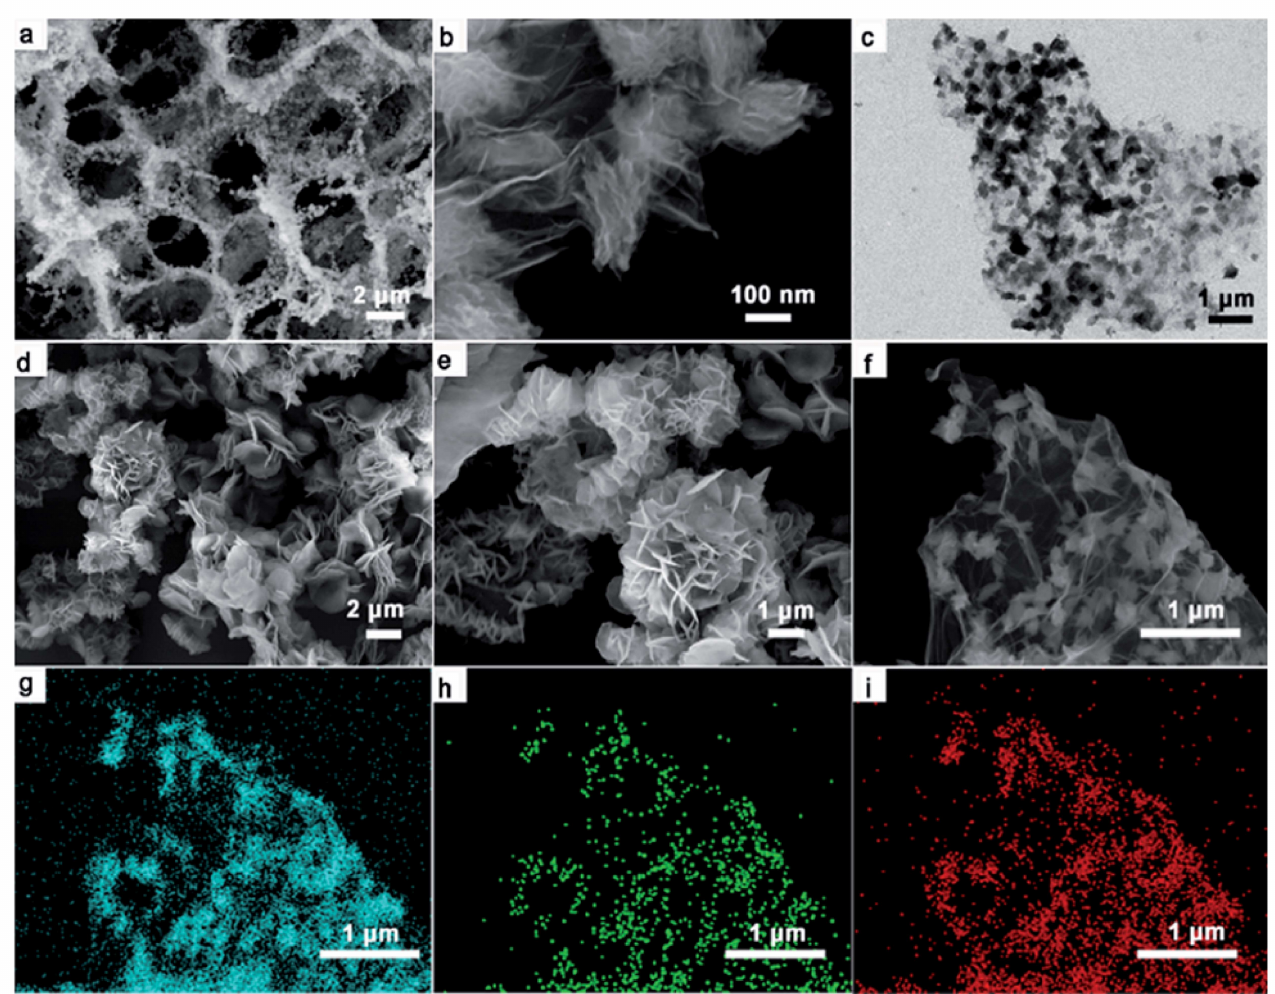
Figure 27. ( a ) Low- and ( b ) high-magnification SEM images and ( c ) TEM image of GF–PI; ( d ) low- and ( e ) high-magnification SEM images of pure PI; ( f – i ) elemental mapping images of GF–PI (by SEM): carbon ( g ), N ( h ), and O ( i ) distribution in the selected area. Adapted and reproduced with permission from Ref. [111]. Copyright 2017 Royal Society of